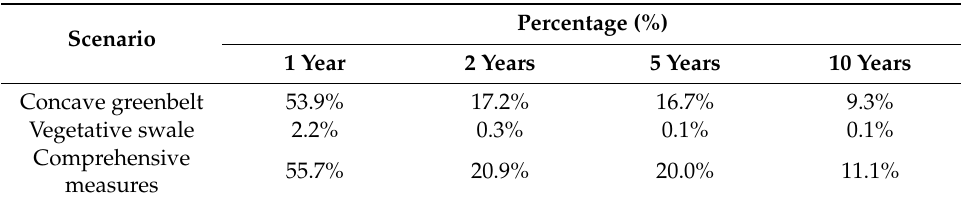
Table 9. Percentages of MRD reduction in different scenarios.